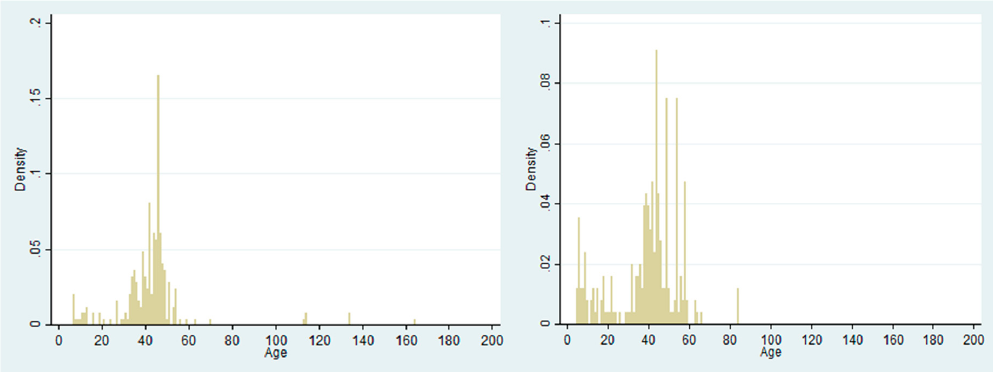
Figure 5. Age of housing units subject to eviction due to foreclosure in Tarragona ( left ) and Terrassa ( right ). Source: own elaboration.